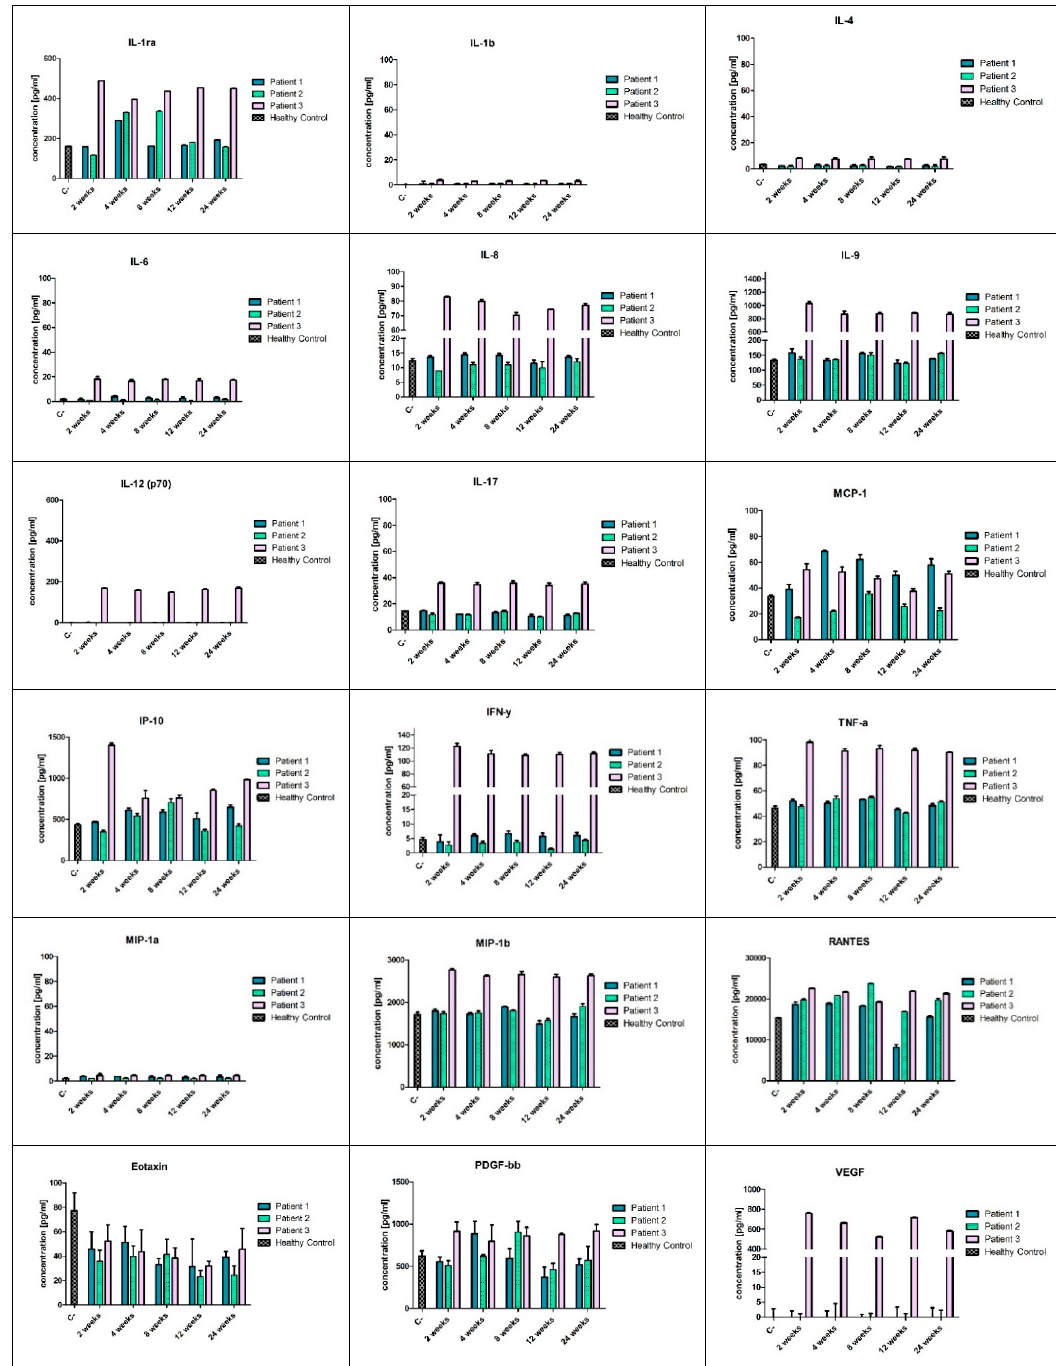
Figure 9. A panel of cytokines, chemokines and growth factors with the multiplex ELISA assay. The cytokine levels in the sera of DMD patients were assessed with reference to the serum levels of healthy controls. Most of the proinflammatory cytokines and chemokines, including IL-1 β , IL-6, IL-8, IL-9, IL-12, IL-17, IFN γ , TNF α , MIP-1 α and MIP-1 β in Patient 1 and 2, were at the levels of healthy controls or slightly below it, such as IFN γ in Patient 2. All analysed proinflammatory cytokines and chemokines were significantly upregulated during the follow-up period in Patient